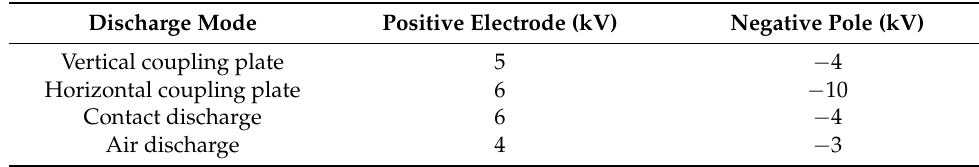
Table 5. Fault threshold of EUT caused by discharge polarity.